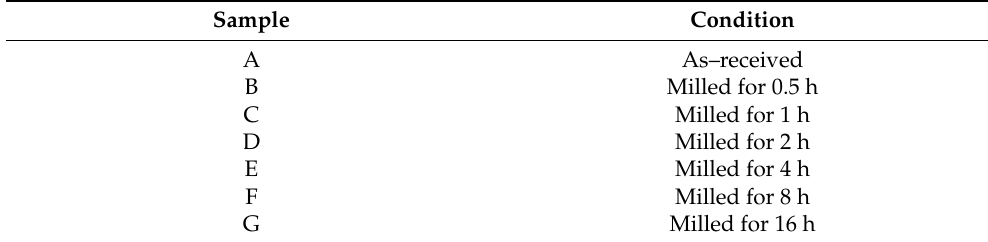
Table 2. Milling time condition of commercial PVA from the as–received